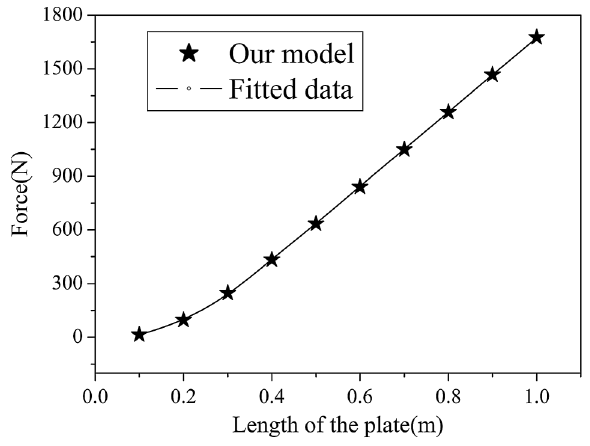
FIG. 13. The variation of the force on the plate due to the eddy current when exposed to a nonuniform time varying magnetic field for various lengths of the plate keeping the width of the plate constant.